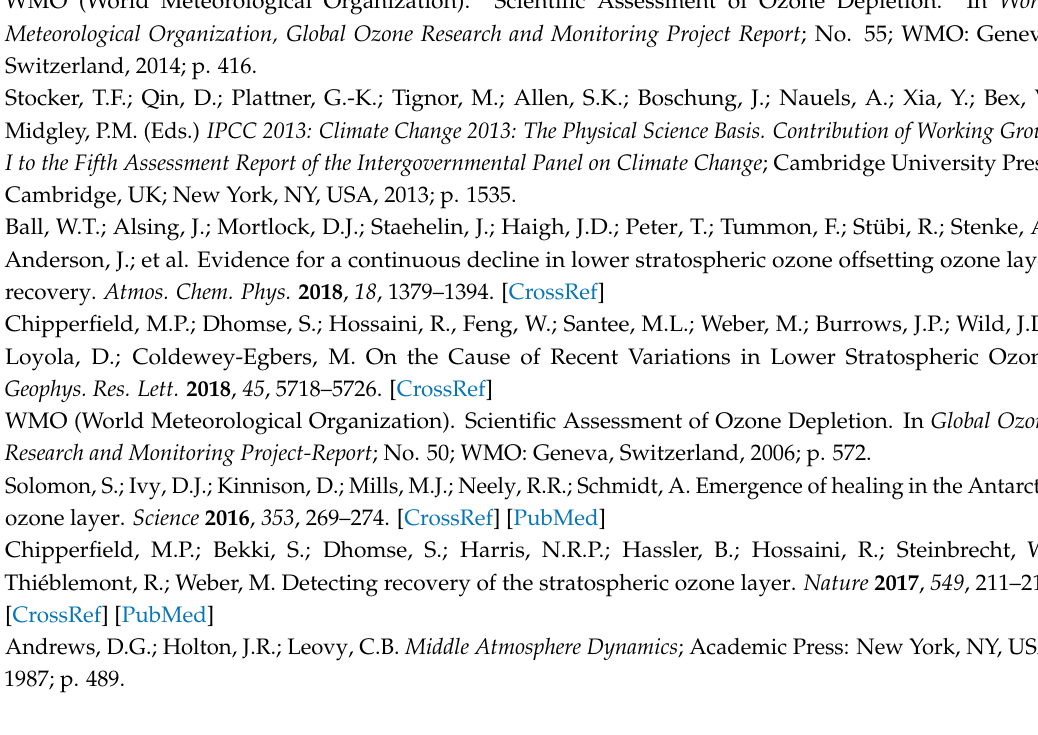
Figure S1: Latitude-height distribution of zonal mean ozone in [DU/km] for ( a ) 1980–2016, ( b ) 1980–1994, ( c ) 1991–2005, and ( d ) 2002–2016 for January using ERA-Interim, Figure S2: Secular trends (linear regression coefficient) of ZATO in [DU/year] for December for the three stages ( a ) 1979–1993, ( b ) 1990–2004, and ( c ) 2001–2015. Cross (single) hatched regions mark statistically significant trends on a 95% (90%) confidence level, Figure S3: Secular trends (linear regression coefficient) of ZATO in [DU/year] for February for the three stages ( a ) 1980–1994, ( b ) 1991–2005, and ( c ) 2002–2016. Cross (single) hatched regions mark statistically significant trends on a 95% (90%) confidence level, Figure S4: Secular trends (linear regression coefficient) of the geopotential disturbance at 300 hPa in [m 2 s − 2 /year] for the three stages: ( a ) 1980–1994, ( b ) 1991–2005, and ( c ) 2002–2016 for December ERA-Interim. Cross (single) hatched regions mark statistically significant trends with a 95% (90%) confidence level, Figure S5: Secular trends (linear regression coefficient) of the geopotential disturbance at 300 hPa in [m 2 s − 2 /year] for the three stages: ( a ) 1980–1994, ( b ) 1991–2005, and ( c ) 2002–2016 for February ERA-Interim. Cross (single) hatched regions mark statistically significant trends with a 95% (90%) confidence level, Figure S6: Trend-like pattern determined by the difference of 5-year means of ZATO for December in [DU/decade]. The three stages are described by the following difference ( a ) 1989/1993–1979/1983, ( b ) 2000/2004–1990/1994, and ( c ) 2011/2015–2001/2005, Figure S7: Trend-like pattern determined by the difference of 5-year means of ZATO for February in [DU/decade]. The three stages are described by the following difference ( a ) 1990/1994–1980/1984, ( b ) 2001/2005–1991/1995, and ( c ) 2012/2016–2002/2006, Figure S8: Trend-like pattern determined by the difference of 5-year means of ZATO for December but using the linear transport model result with contributions of wave 1–4, Figure S9: Trend-like pattern determined by the difference of 5-year means of ZATO for February but using the linear transport model result with contributions of wave